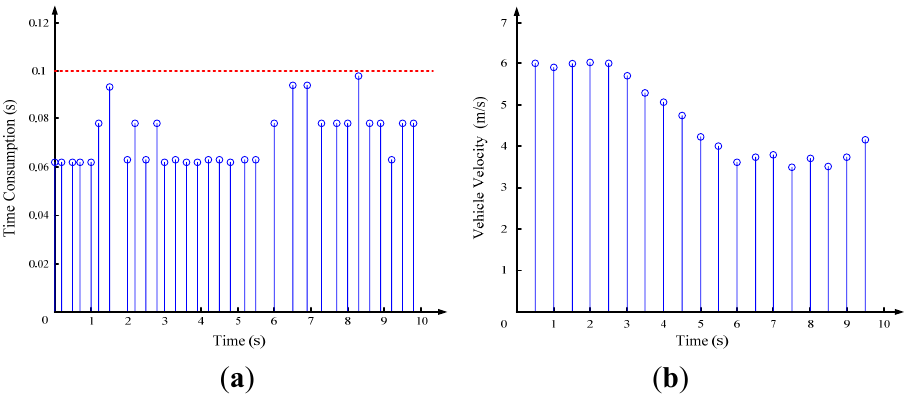
Figure 11. ( a ) Time consumptions of window constraint Markov localization process. ( b ) Vehicle velocities during experiment. ( c ) Localization deviations ( dx ) between the odometer and WCML along the east direction. ( d ) Localization deviations ( dy ) between the odometer and WCML along the north